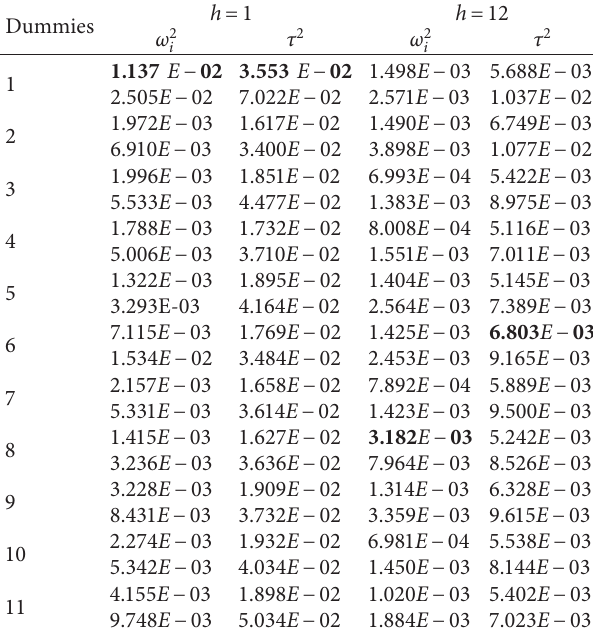
Table 5: Posterior means and standard deviation of ω 2 monthly